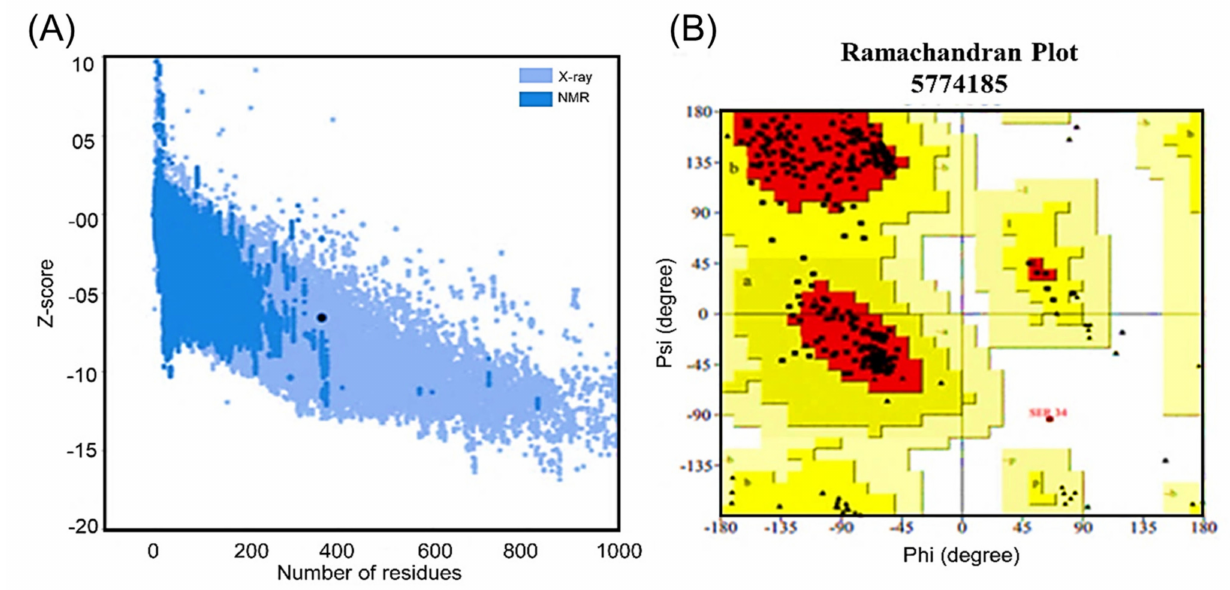
Figure 5. Analysis of the Ramachandran (PROCHECK) and PROSA-web servers. Panel ( A ) shows the ProSA-web analysis with the depicted Z score ( − 6.54) indicating a valid 3D structure. Panel ( B ) shows the Ramachandran plot with the amino acid distribution in the allowed and disallowed regions and favored regions. It also shows the higher percentage (92.4%) of residues in the favored region, followed by the lower percentage (7.3%) of residues in the allowed region, and the lowest percentage (0.4%) reported in the disallowed region before the MD simulation.